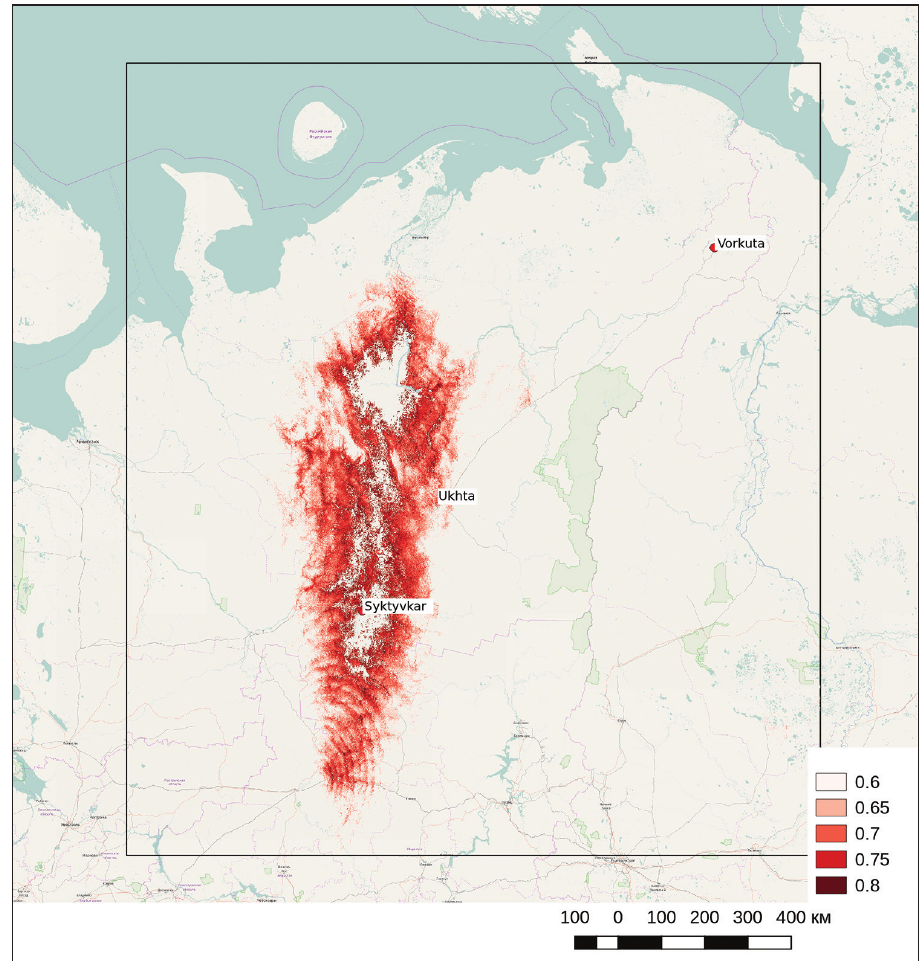
Figure 3. The prediction map of Heracleum sosnowskyi habitats prepared with the species distribution model based on bioclaimatic predictors. The borders of Plot 2 within which the model prediction was made. The colour scale shows the probability H. sosnowskyi